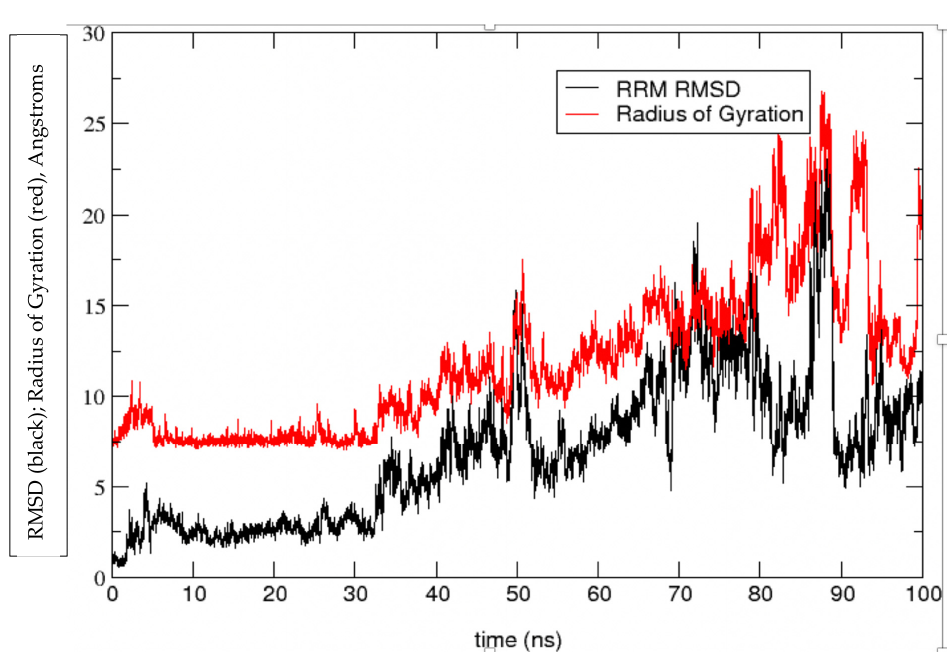
Figure 3. Radius of Gyration (red line) and RMSD (black line) of the RNA recognition motif of U1A with respect to the initial structure of MDUF simulation #1 on U1A. An RMSD vector representation of the MDUF trajectory for U1A in a 2D projection of the 3D RMSD space is shown in Figure 4. The onset of UF transition occurs in the region of ~1.18–1.19 ns (indicated as a red sphere). Using the methodology described in the pre- ceding section, a population map was obtained and converted to a statistical free energy landscape. The result is presented as a contour map in Figure 5. This describes the MD UF transition as proceeding from the native state (lower left corner) over a free energy barrier and continuing along a relatively extended valley on the surface. A UF reaction coordinate is constructed from perpendiculars to the isoenergy contour lines. The free energy for the first 5 ns of MD simulated unfolding of U1A as a function of this coordinate is plotted in Figure 6. The plot indicates an activation free energy of 3.8 kcal/mol. Using the transition state theory for proteins [1] the k u is approximately 10 6 exp(- Δ F/RT) which computes to 2.7 × 10 ‒ 3 s − 1 . The free energy profile in Figure 6 for the first 5 ns of MDUF shows that the activation process is to be followed by a slight free energy minimum before unfolding further. However, the well depth of this minimum is only ~0.2 kcal/mol, so this does not correspond to a thermally stable intermediate. Thus, the MD UF results on U1A describe a two-state process.